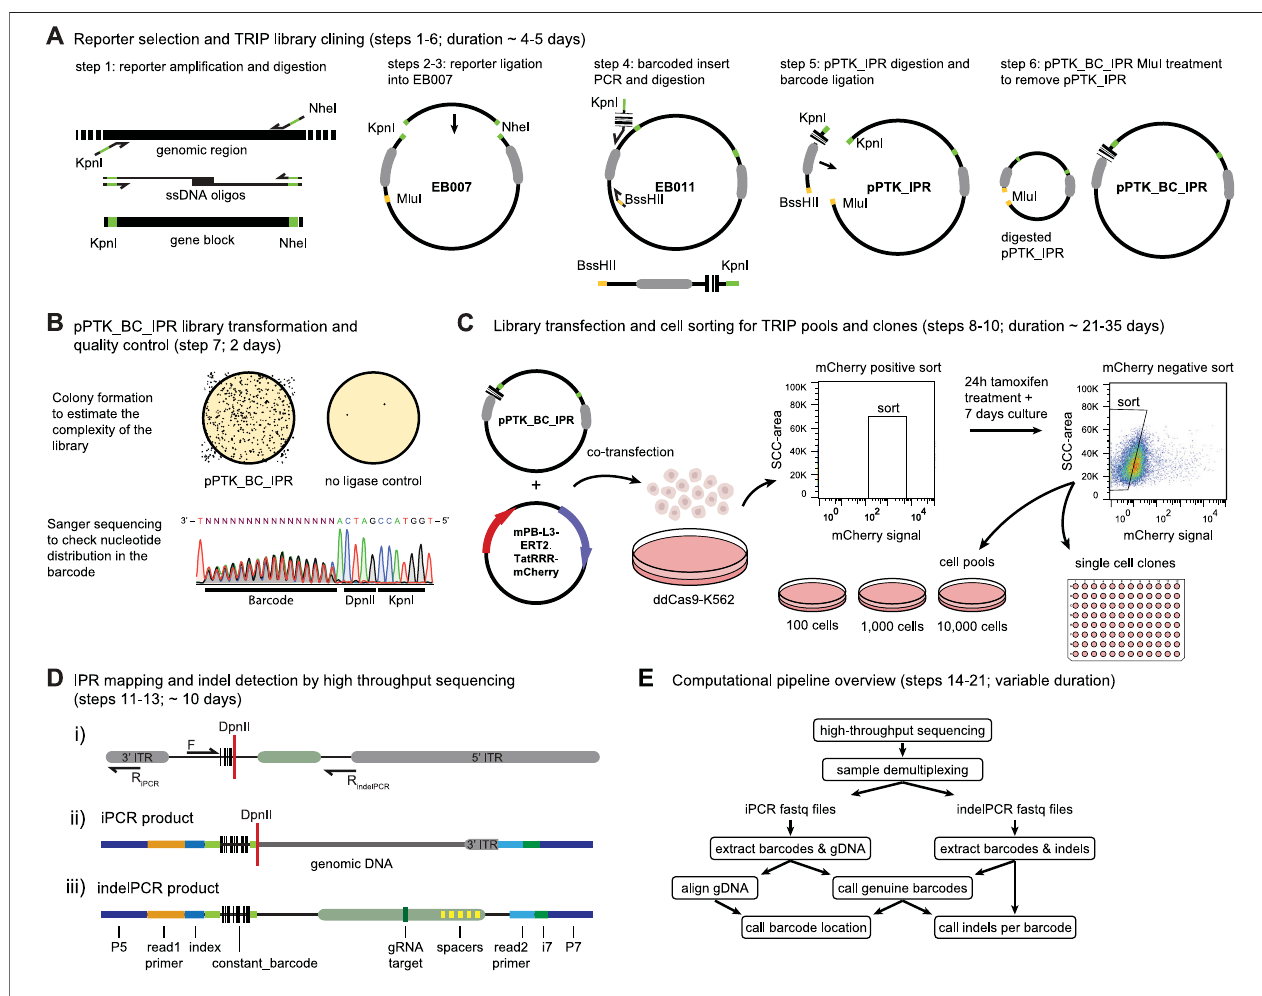
FIGURE 3 | Step by step DSB-TRIP. (A) DSB-TRIP cloning steps. DNA sequences are in black, important restriction enzyme sites in green and orange and the PiggyBac ITRs are in grey. (B) Library quality control. Top: assessing the complexity of the library by counting the colonies. Bottom: A Sanger sequence track from step 7, spanningthebarcodeandtheDpnIIandKpnIrestrictionsitesintheplasmidlibrary,Thesequenceis fl ippedtomatch fi gureorientation.Allthebasesareequallypresentinthe 16 bpbarcode. (C) LibrarytransfectionandFACSsortingstrategytogeneratepoolsandclones. (D) i)SchemeoftheIPRwiththemainprimersusedforgeneratingthe mapping (F & R iPCR ) and the indel (F & R indelPCR ) sequencing libraries. DpnII restriction site is indicated with a red line. ii) Scheme of a raw iPCR library PCR product, created from the circularisation ofthe fragment by ligation ofa genomic DpnII site with the DpnII site from above. From left to right: P5 Illumina adapter, read1 primer site, 16 bp IPR barcode, DpnII restriction site in red, genomic DNA dark gray, 3 ′ ITR in light gray, i7 Illumina index, P7 Illumina adapter. iii) Scheme of a raw indelPCR library PCR product, indicating the Illumina adapter and primerlocations (P5,read1 primer, read2 primer, i7and P7) aswellasconstant sequencesrelated tothe con fi g fi le. From lefttoright:P5 Illuminaadapter,read1Illumina primer,index,constant_barcode (lightgreen)with16 bpIPRbarcode embeddedinbetween, LBR sequencecontainingtheCas9targetsite (dark green) and multiple spacers in yellow (spacer_list), read2 Illumina primer, i7 Illumina index, P7 Illumina adapter. (E) Diagram of the analysis pipeline.